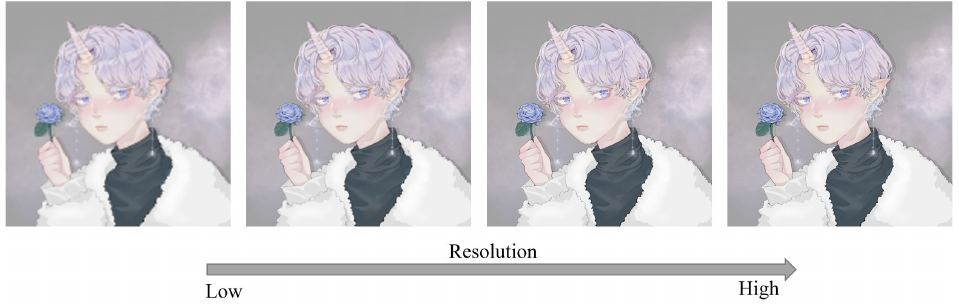
Figure 1. Anime image changes at different resolutions. The anime image resolution gradually increases from left to right. The image is adopted from [3]. We were given authorization to use an illustration copyrighted by Ms.